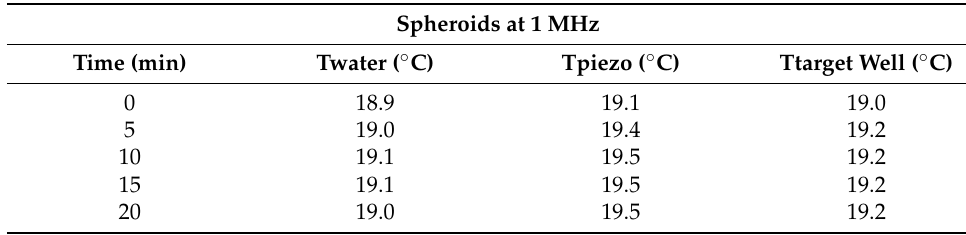
Table 1. Average temperature values calculated at 1 MHz.